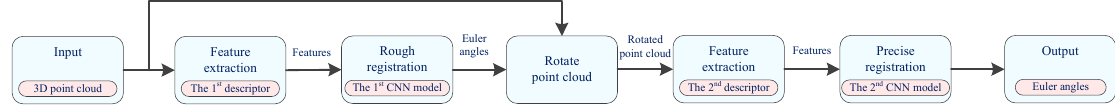
Figure 3. A comprehensive block diagram of the proposed registration architecture.